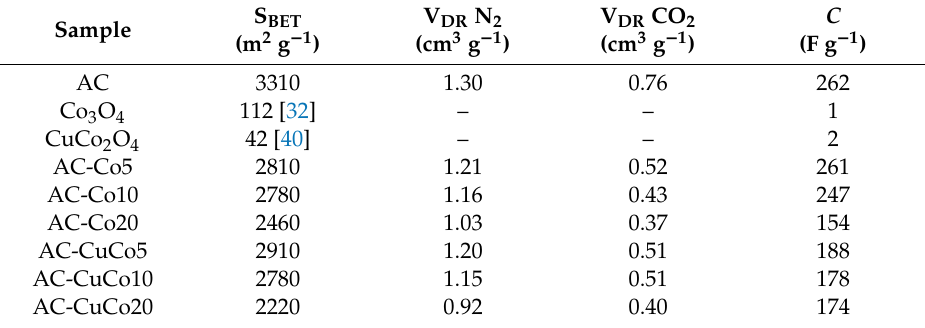
Table 3. Textural parameters obtained by N 2 and CO 2 isotherms for pristine AC-Co x and AC-CuCo x hybrid materials. The last column shows the gravimetric capacitance derived from cyclic voltammetry